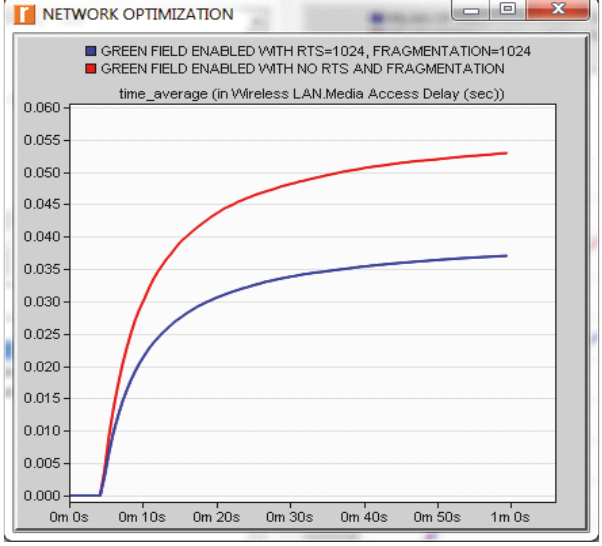
Figure 31: WLAN media access delay for optimized value of RTS, fragmentation, and Greenfield operation parameters.